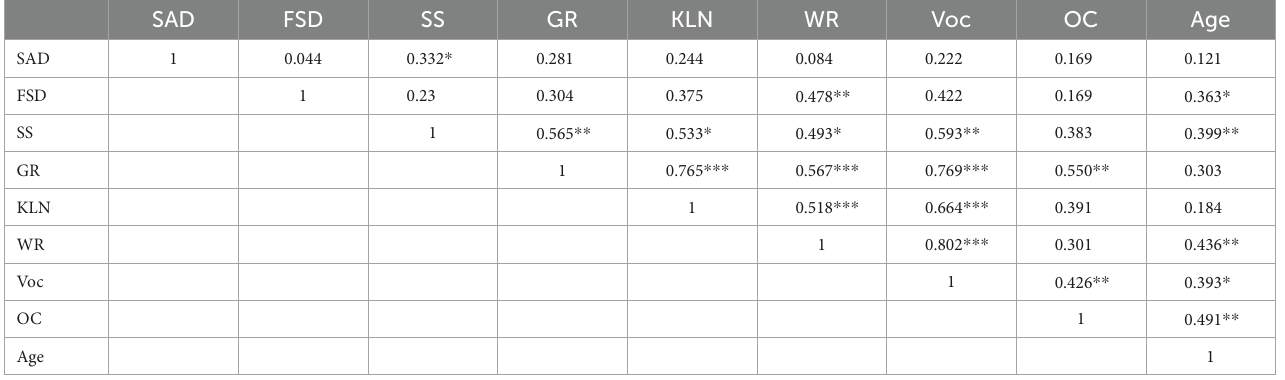
TABLE 3 Simple correlations between variables of interest and age in